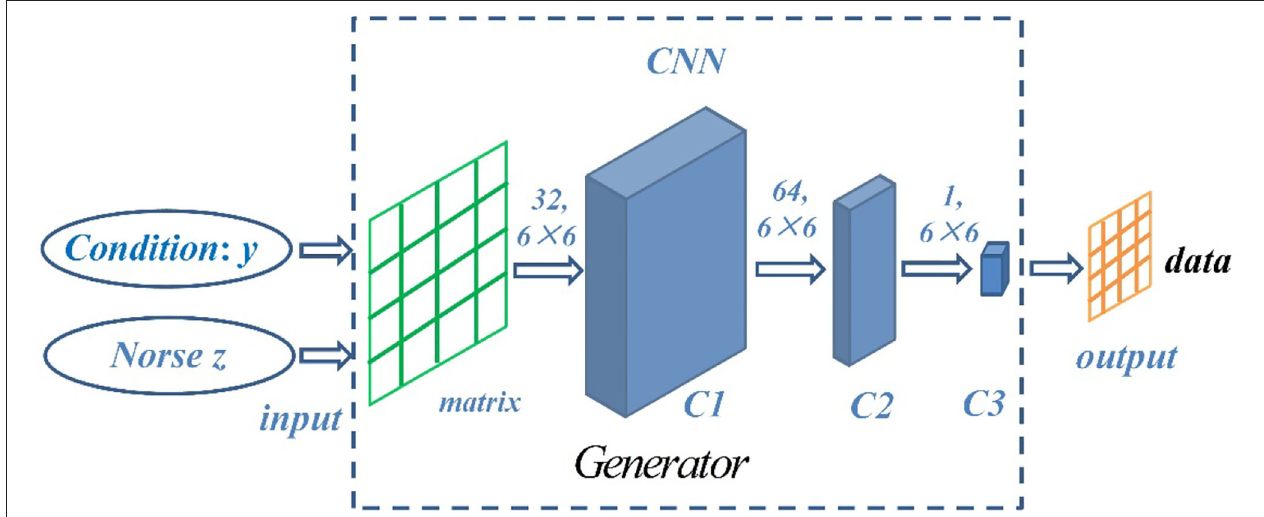
FIGURE 4 | Network structure of